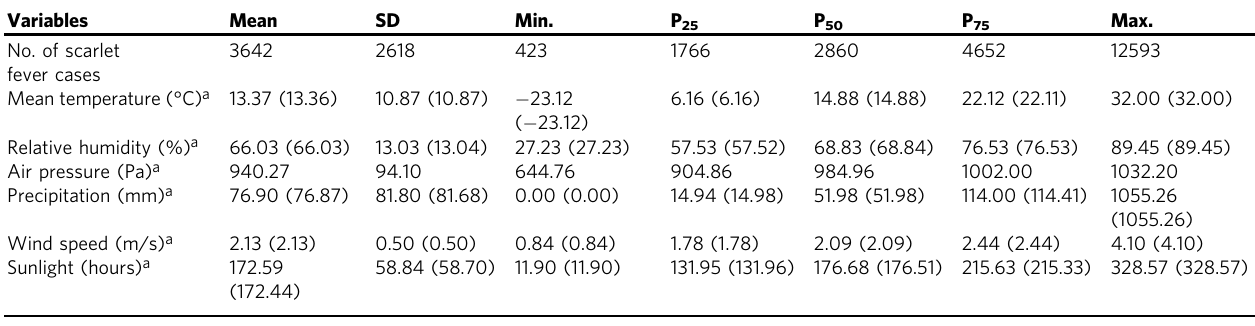
of NO 2 at lag 0 months. The maximum RR of O 3 was 1.14 under exposure to 198 of O 3 at lag 0 months. PM 2.5 and PM 10 were not included in the multiple-variables model because of their collinear relationship with NO 2 . Relationship between weather condition and scarlet fever . The DLNM model further discovered that fi ve of the six meteor- ological variables (all but air pressure) had a signi fi cant associa- tion with scarlet fever incidence. Two meteorological conditions showed positive relationships with the disease: monthly sunlight ( r = 0.27) and wind speed ( r = 0.24); by contrast, it was inversely correlated with monthly relative humidity (RH, r = − 0.37),